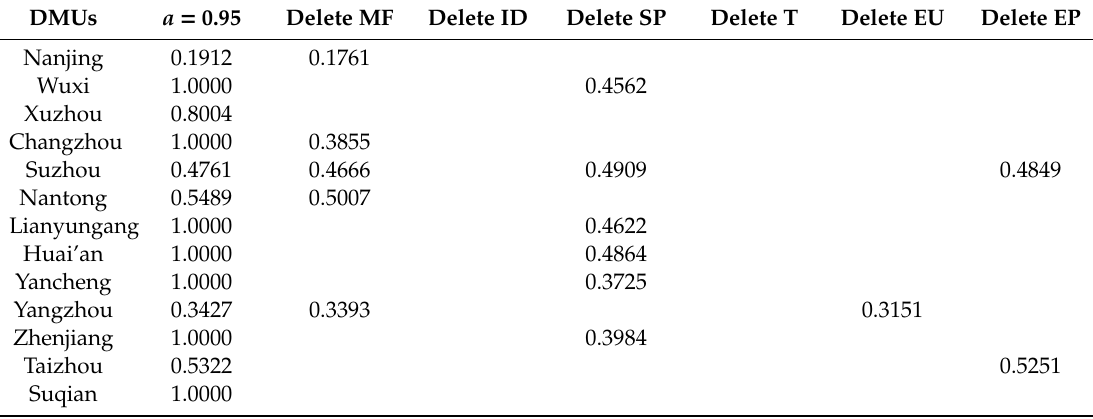
Table A3. The changes of stochastic e ffi ciency value by deleting grouping input variables in 2015 ( α = 0.95).